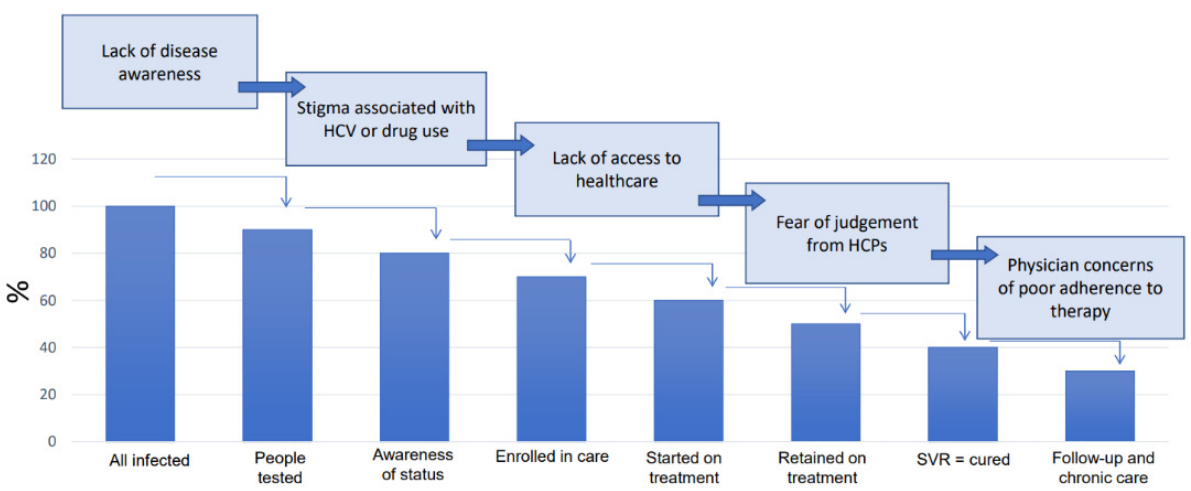
Figure 5. WHO cascade of care. HCP—healthcare professional, SVR—sustained virological response (adapted from: World Health Organization. Global hepatitis report, 2017. Geneva: World Health Organization [7]).